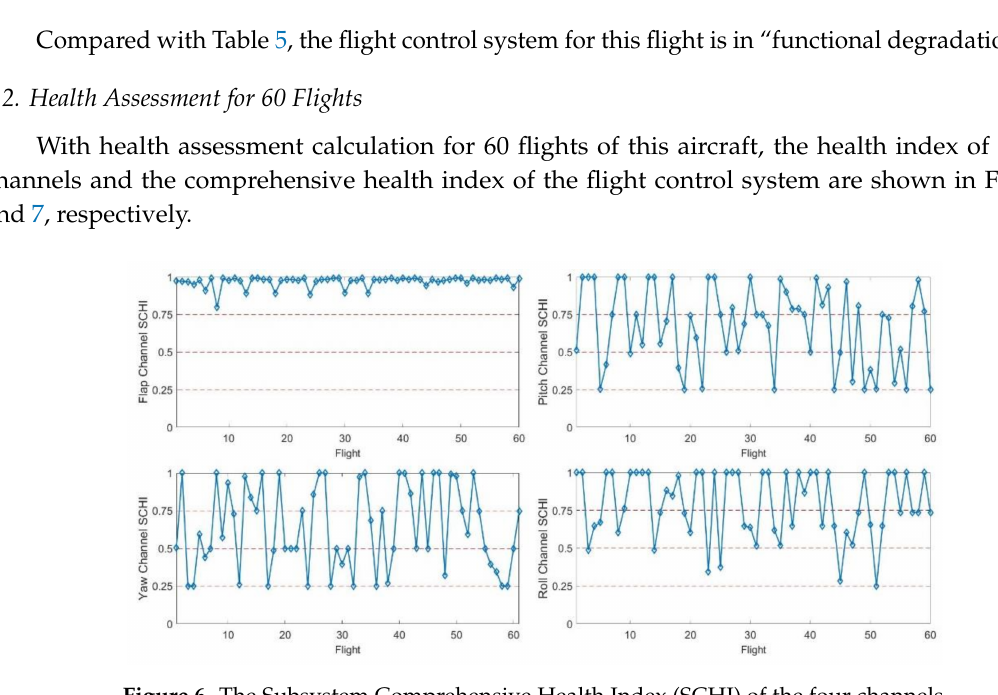
Figure 6. The Subsystem Comprehensive Health Index (SCHI) of the four